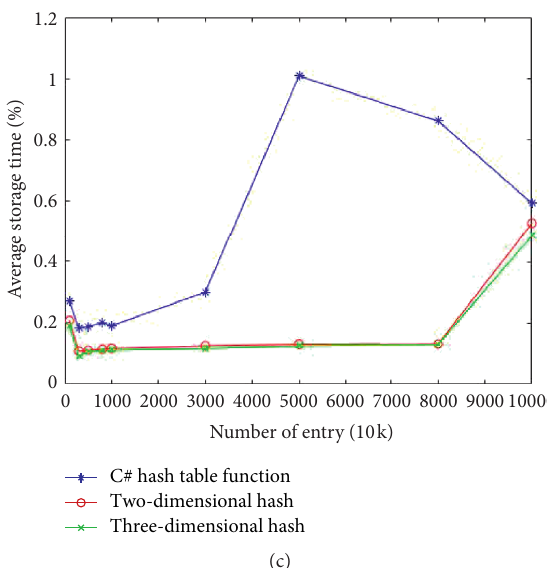
Figure 11: Comparison on average storage time at (a) 0.5 fill rate; (b) 0.75 fill rate; (c) 1.0 fill